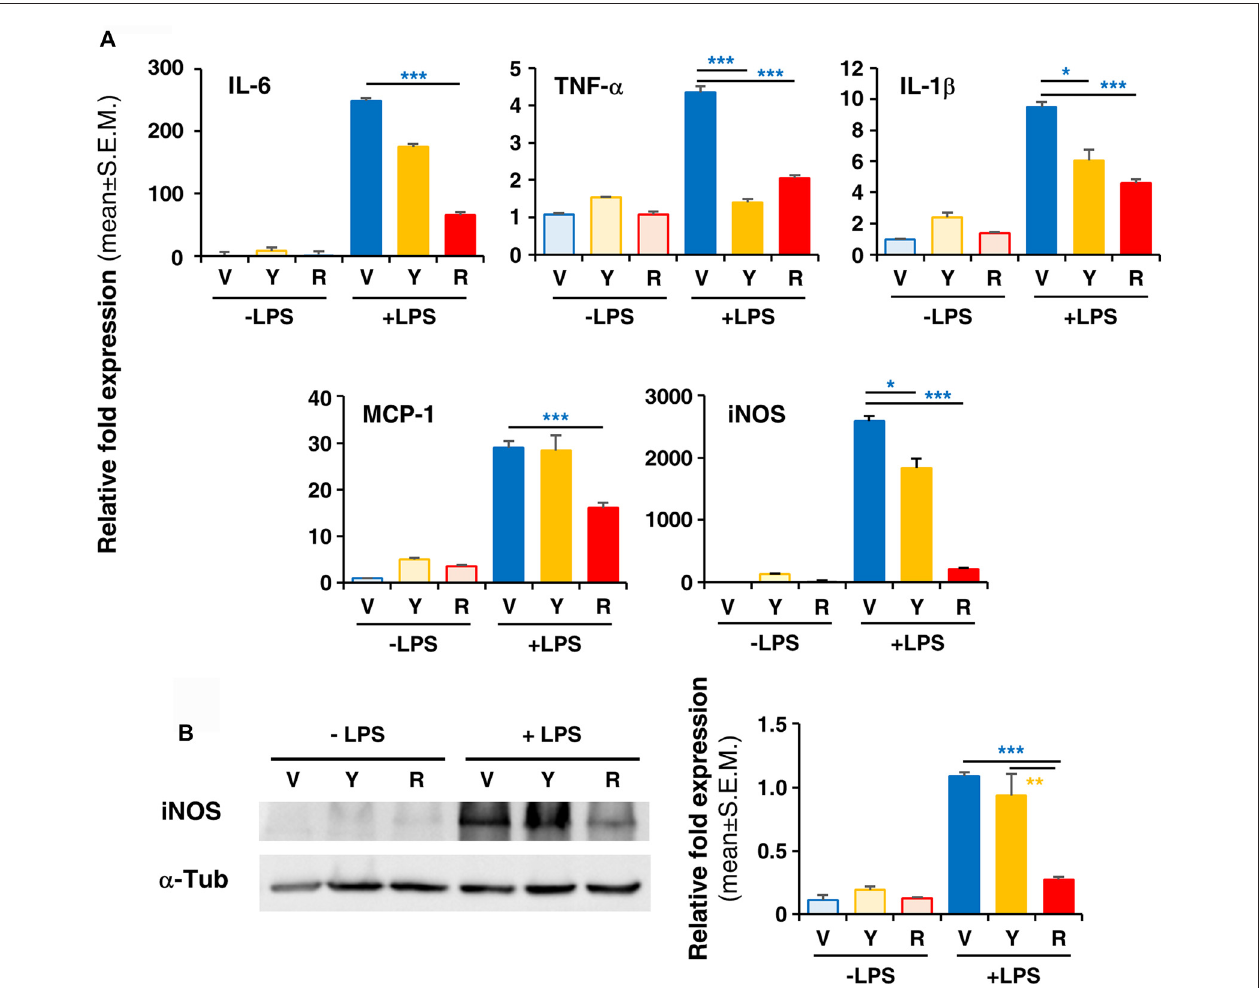
FIGURE 4 | In vitro treatment of LPS-activated rodent microglia with Red extract reduces the production of pro-inflammatory mediators. Rodent microglia cells were grown in culture, overnight exposed to medium alone, Yellow or Red extracts, and then challenged with medium alone or 1 µ g/ml LPS for 6 h (see “Materials and Methods” section for details). Cells were then collected and the expression of pro-inflammatory cytokine genes was evaluated by Real time RT-PCR (A) . Each transcript was normalized to corresponding control value (V, vehicle). Values shown are mean ± SEM from two independent experiments performed in triplicate. (B) Evaluation of iNOS protein levels by Western blotting and relative quantification. Filter is from one representative experiment out of three (see Supplementary Figure S2 for the specificity of antibodies). Densitometric analysis of bands have been performed with ImageJ and values normalized to α -tubulin. Histograms show the mean ± SEM values from three independent experiments performed in triplicate. ∗ p < 0.05, ∗∗ p < 0.01, and ∗∗∗ p < 0.001 with respect to cultures exposed to Red extract, one-way ANOVA followed by Bonferroni post hoc